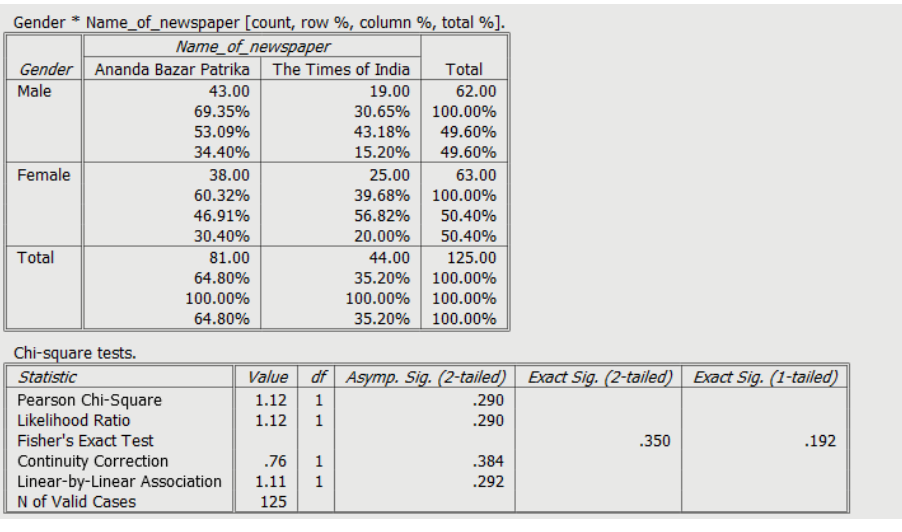
Figure 2: Cross Tabulation and Chi-square between Gender v/s Newspaper Read (Source: Authors‟